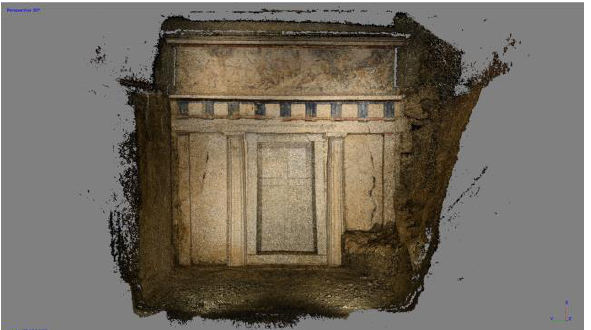
Figure 5. Tomb of Philip II in Verghina. Cloud of points with noise.